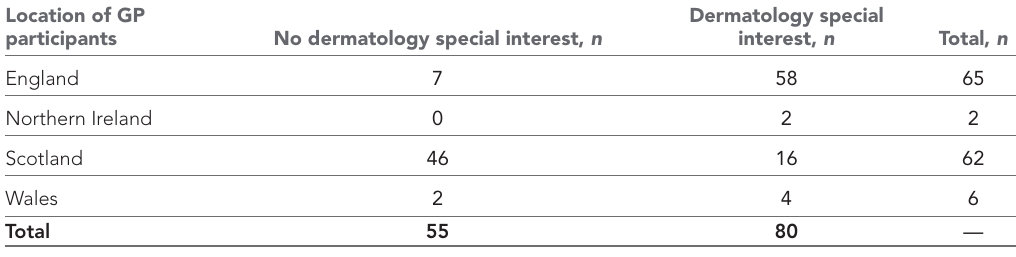
Table 1 Proportion of GPs with dermatology special interest and location of practice Location of GP